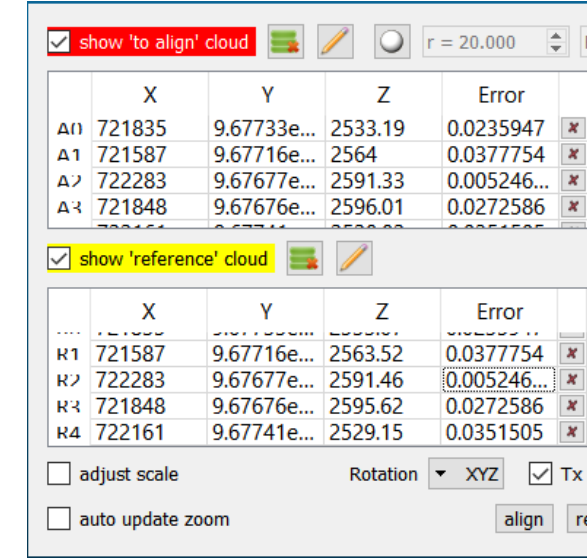
Figure 10. Geo-referencing errors, UAV – UAV. Table 8 . Processing times for geo-referencing of